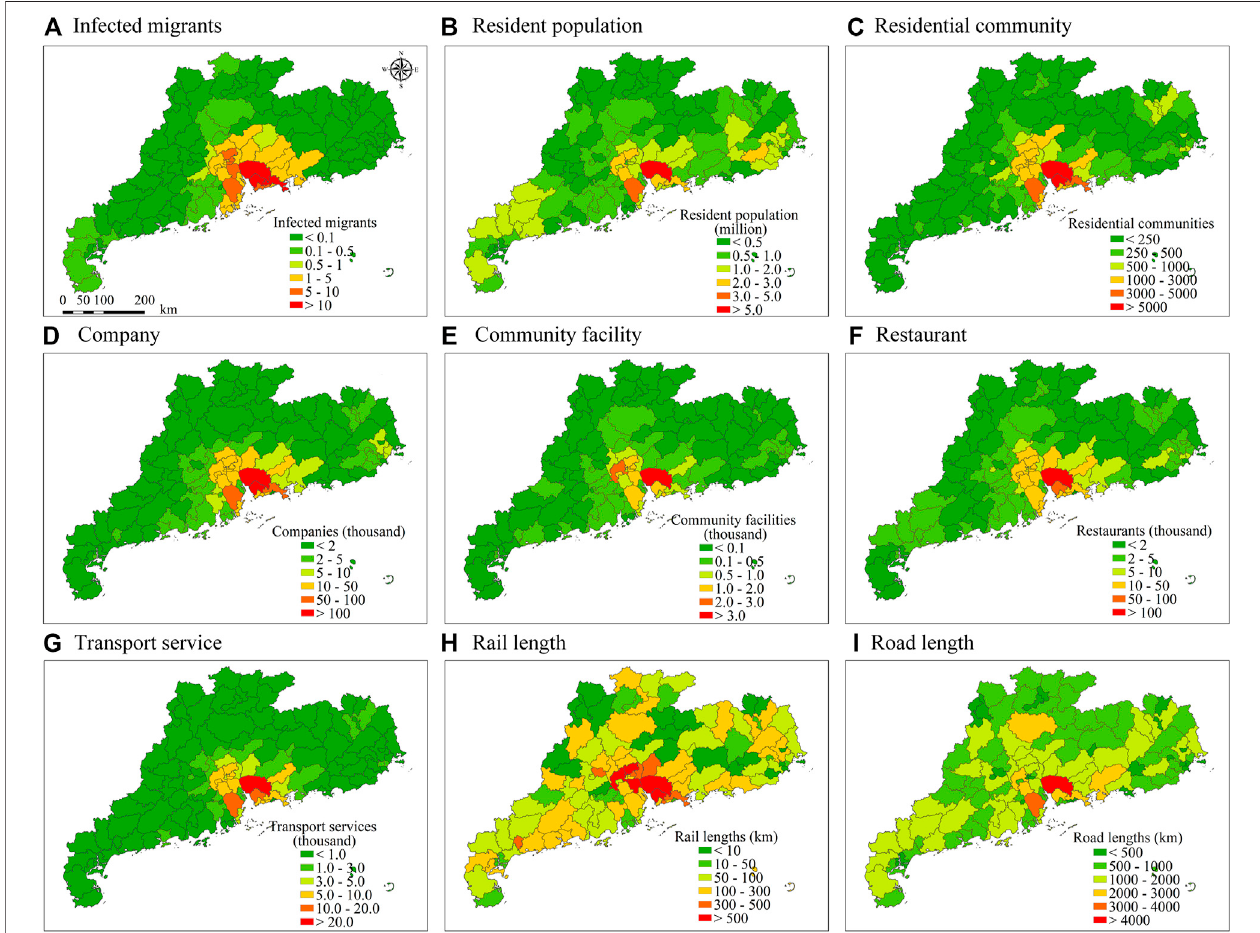
FIGURE 2 | Categorized maps of nine factors in relation to the COVID-19 epidemic at the county level in Guangdong Province.